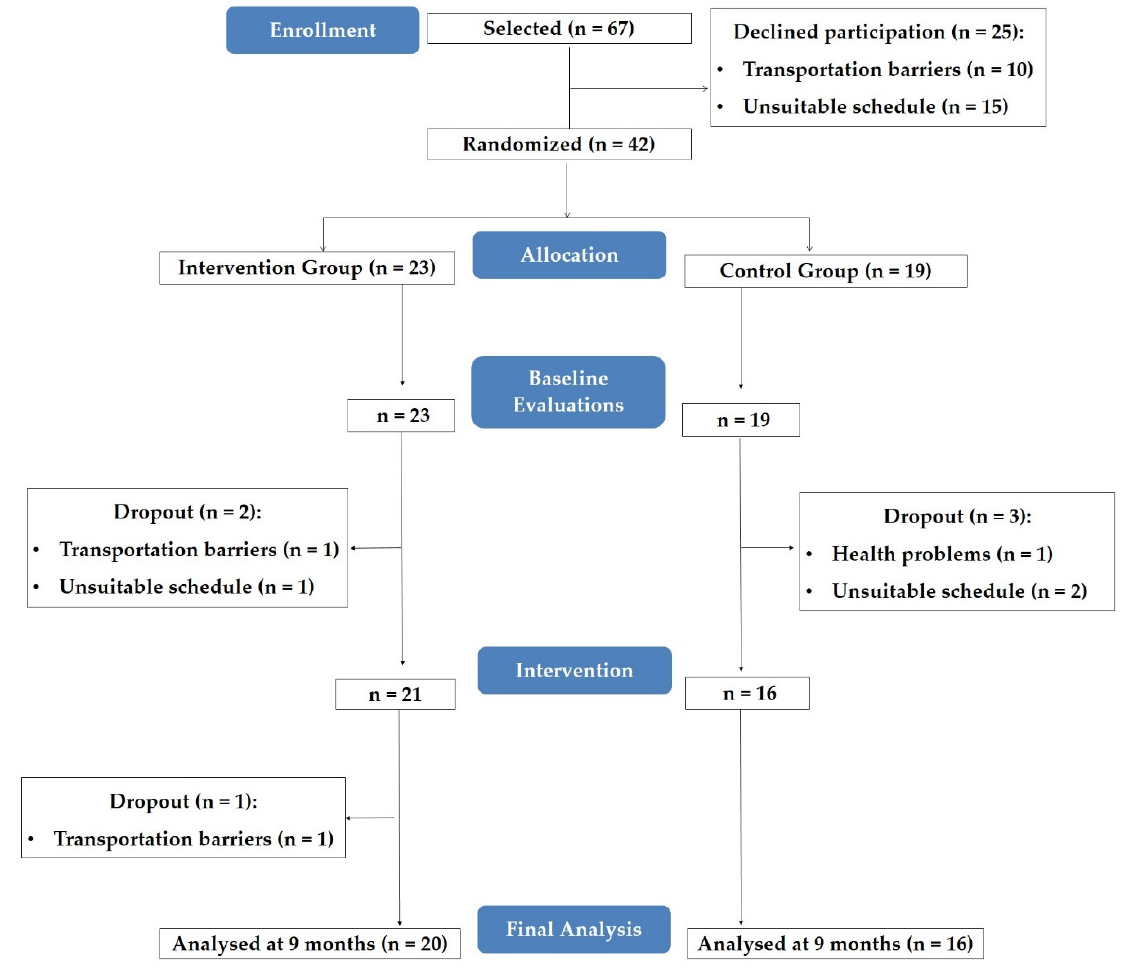
Figure 1. Participants’ flow chart.